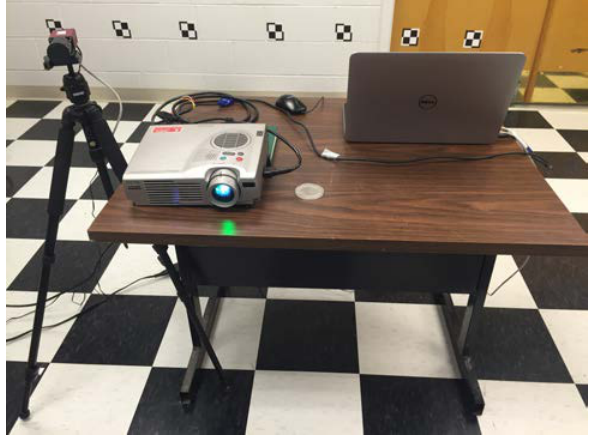
Figure 1: Setup of the structured light 3D scanning system